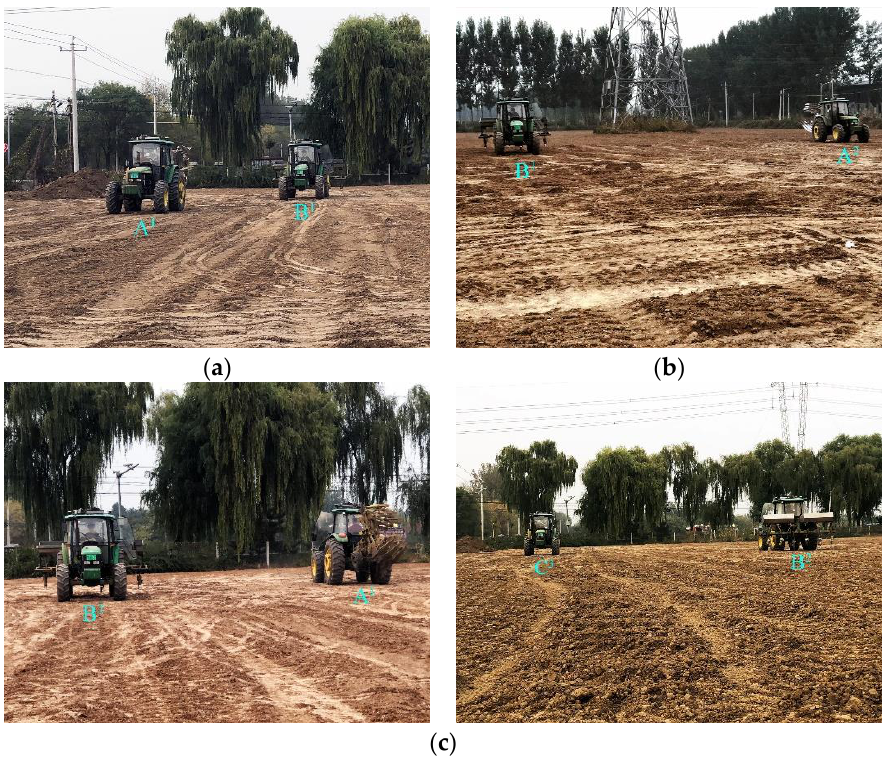
Figure 14 . Field experiments scene of ( a ) ES1, ( b ) ES2, and ( c ) ES3.